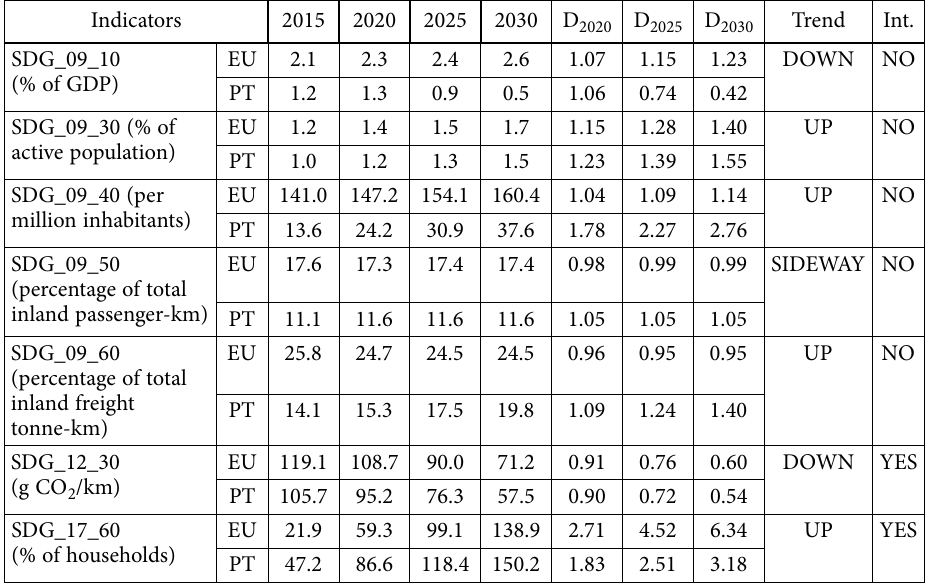
Table 10. SDG 9 – Industry, innovation and infrastructure